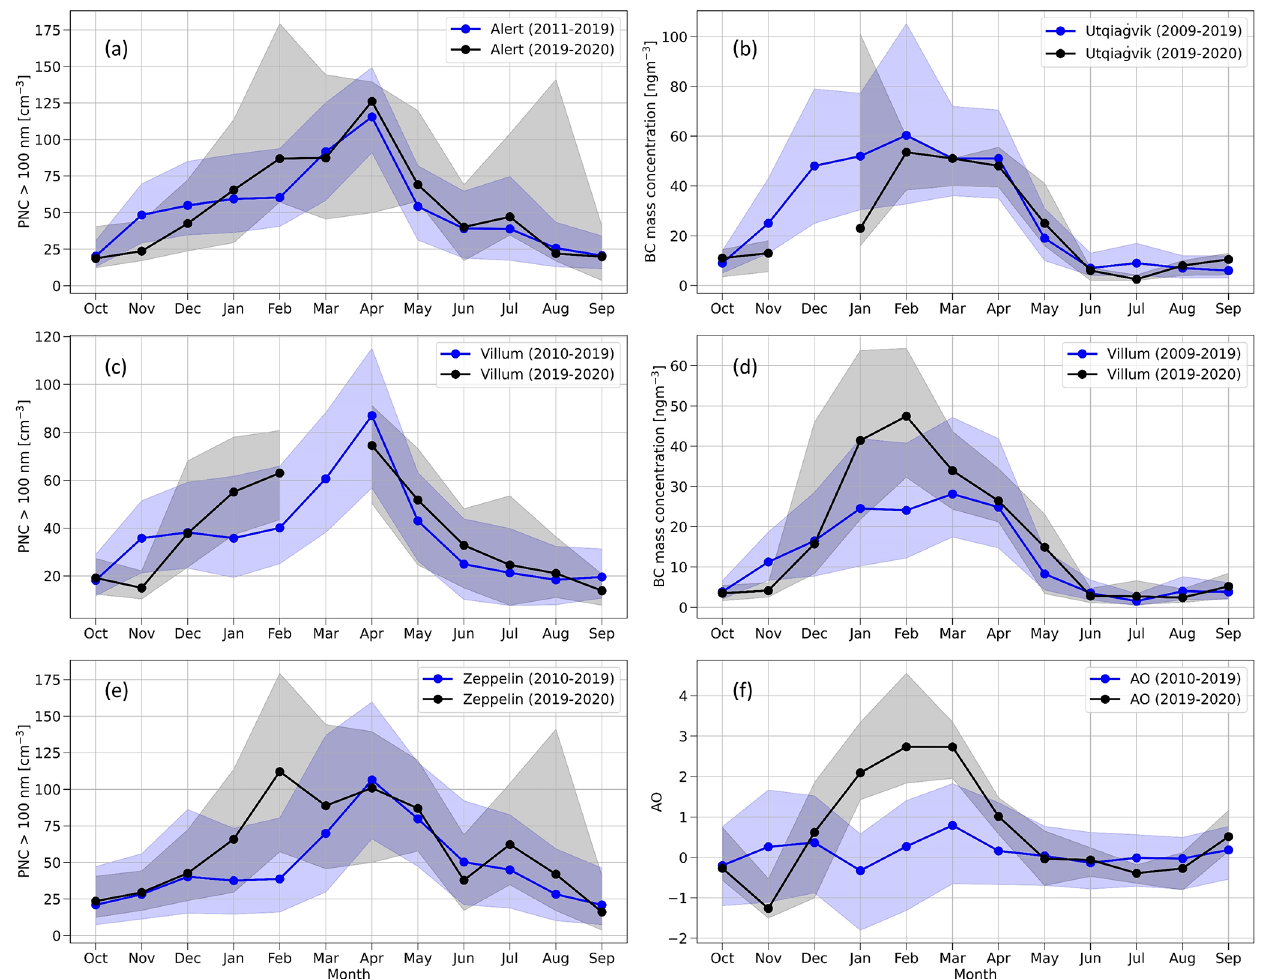
Figure 12. The influence of AO on aerosol observations during MOSAiC. The six panels show the year of the MOSAiC campaign (2019– 2020) compared to the trend over the past decade (2010–2019) for (a) the PNC > 100nm at Alert, (b) the BC mass concentration at Utqia˙gvik, (c) the PNC > 100nm at Villum, (d) the BC mass concentration at Villum, (e) the PNC > 100nm at Zeppelin, and (e) the AO index. The data are presented as the monthly medians, and the shaded regions show the interquartile range. It is important to note that AO is a wintertime phenomenon; the complete year is included in the plots for